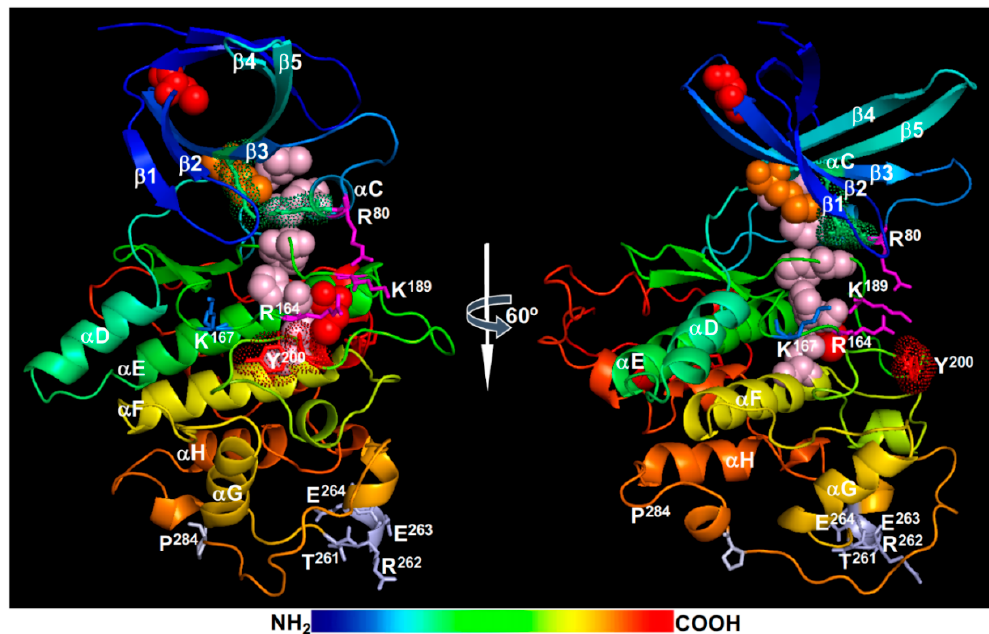
Figure 5. A structural model of BIN2. Shown here are two rotational (0° and 60°) views of a modeled BIN2 structure obtained at SWISS-MODEL (https://swissmodel.expasy.org/). Individual β -strands ( β 1- β 5) and α -helices ( α C- α H) were labeled. The two extra antiparallel- β -strands that cap the N-lobe are not labelled. The TREE motif and the Pro 284 residue mutated in known bin2 / dwarf12 / ucu1 alleles are indicated with grey-colored sticks. The magenta sticks show the three positively charged residues [Arg 80 , Arg 164 , and Lys 189 (also acetylated)] of the conserved phosphate-binding pocket, the red sticks with red dots denote the Tyr 200 residue, the green sticks with green dots mark the Lys 69 -Glu 81 salt bridge between the β 3-strand and the α C-helix, and the blue sticks represent the Lys 167 residue that corresponds to the acetylated Lys 183 residue of the human GSK3 β . The red spheres show the Cys residues that were shown to be S-nitrosylated or S-glutathionylated in vitro, the orange spheres indicate the gatekeeper Met 115 residue, and the pink spheres mark the 5 R-spine residues (from lower to top: Asp 223 , His 163 , Phe 185 , Met 85 , and Leu 96 ). Important residues are also labelled with single letter codes with positions. The rainbow bar indicates the order of AAs from the N-terminus (blue) to the C-terminus